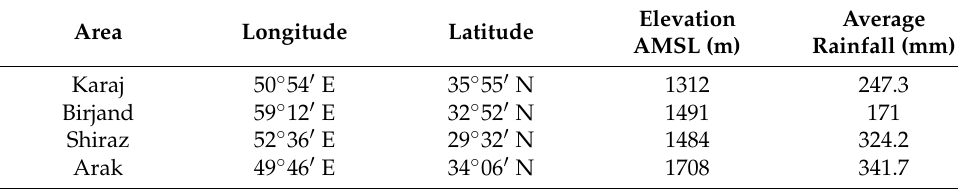
Table 1. Geographical specifications of Performed the experiment